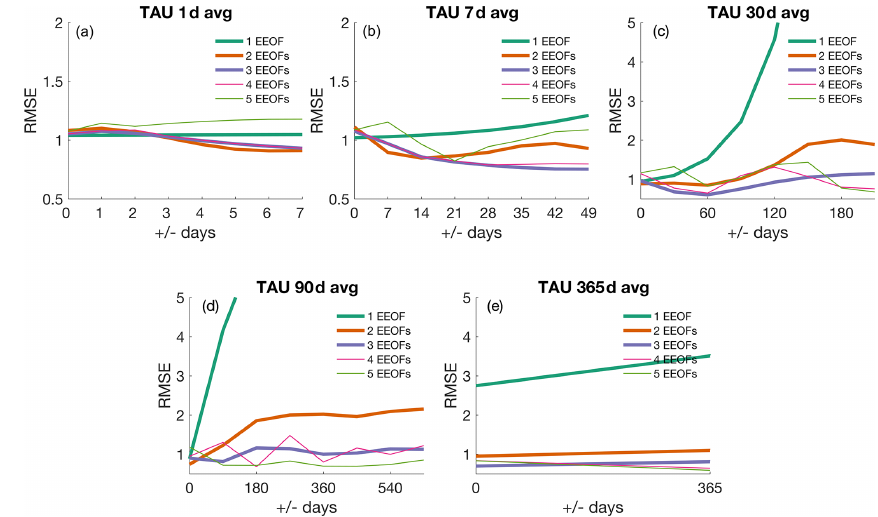
Figure 4. Root mean square error of reconstructed wind stress with respect to actual wind stress using (a) daily data, (b) 7d averaged data, (c) 30d averaged data, (d) 90d averaged data, and (e) 365d averaged data.